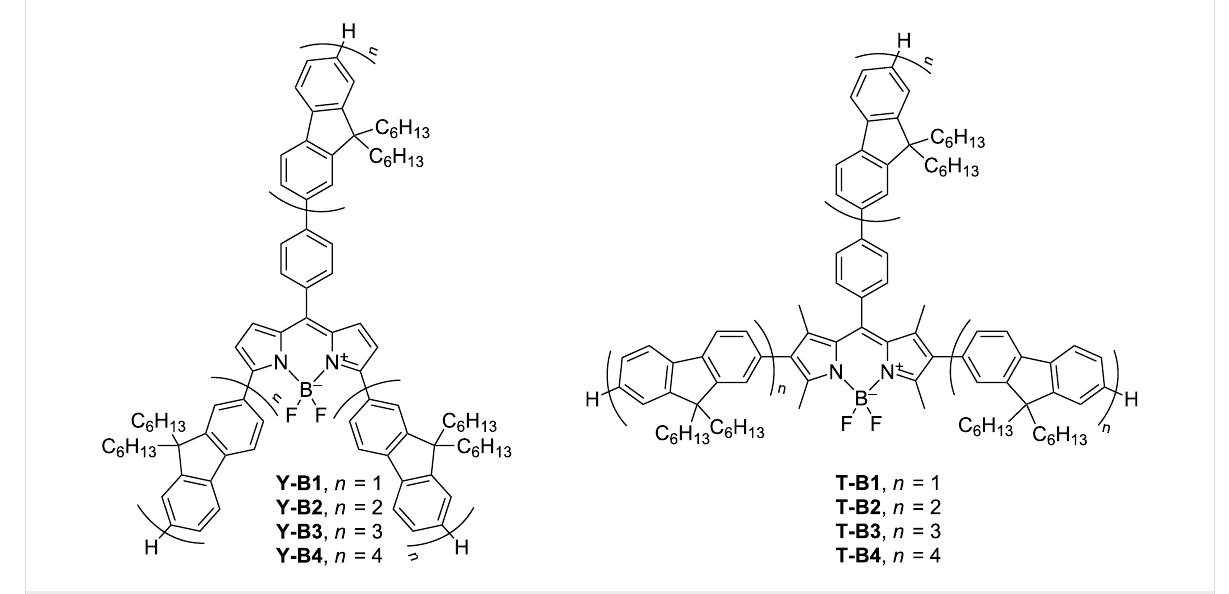
Figure 1: The structures of the star-shaped oligofluorenes with BODIPY cores, Y-Bn ( n = 1–4) and T-Bn ( n =